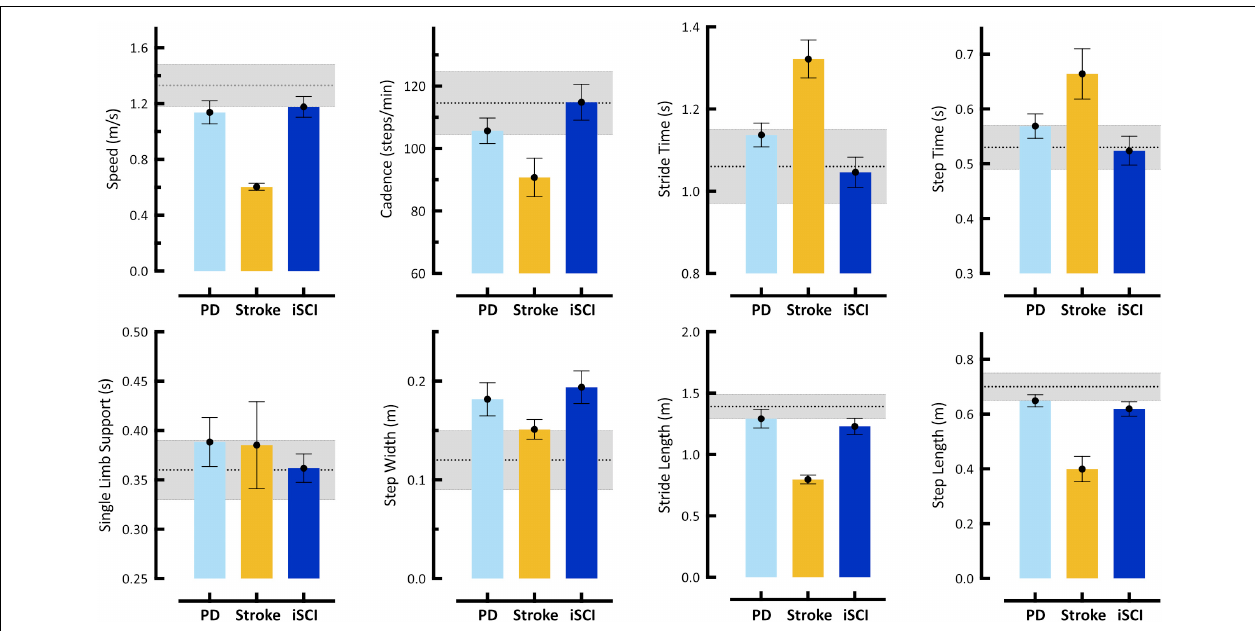
FIGURE 2 | Spatiotemporal gait parameters acquired using markerless motion capture during self-selected (SS) walking task. Bars represent single subject mean (SD) for: Case 1 – 61 year old male with Parkinson’s disease (PD), Case 2 – 77 year old female stroke survivor with hemiparesis (Stroke), and Case 3 – 66 year old male with incomplete Spinal Cord Injury (iSCI). Gray shaded region in each plot represents mean (SD) from our reference control group. Error bars of individual subject means reflect SD of all steps taken. Individual cases are discussed in detail in Section “Case Studies – Detecting Neuropathology with 3D Kinematics.” These data reveal differences with respect to reference controls in one (PD, iSCI) to six (Stroke), but not all eight, spatiotemporal parameters in any individual. Notably, analysis of spatiotemporal variables only might not identify Cases 1 and 3 with neurologic pathologies. Furthermore, these descriptive differences provide little-to-no explanation regarding the causal mechanism of gait